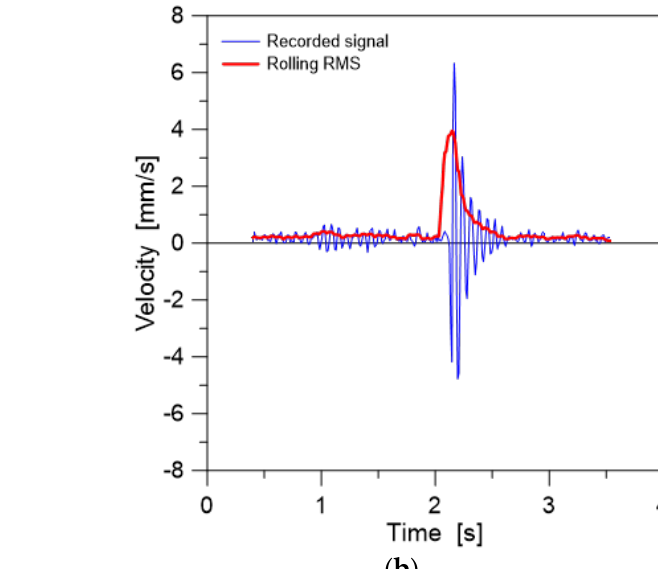
Figure 11. Qualitative example of typical ( a ) acceleration and ( b ) velocity experimental signal due to a single footfall of the involved volunteer.